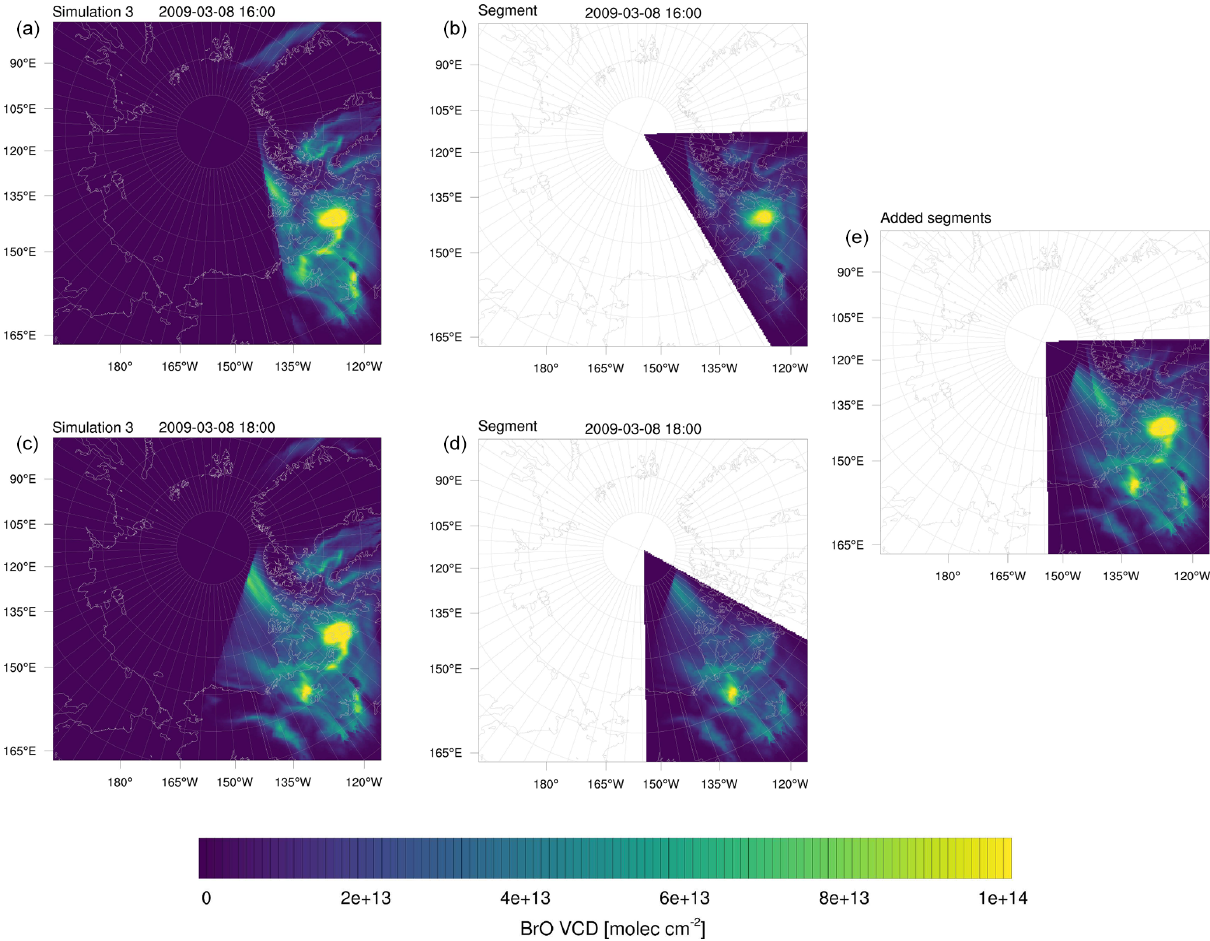
Figure 12. Illustration of the averaging of modeled BrO VCDs. Shown is 8 March 2009, 16:00 and 18:00UTC. (a, c) Full instantaneous BrO VCDs. (b, d) Corresponding 60 ◦ segment. (e) Added